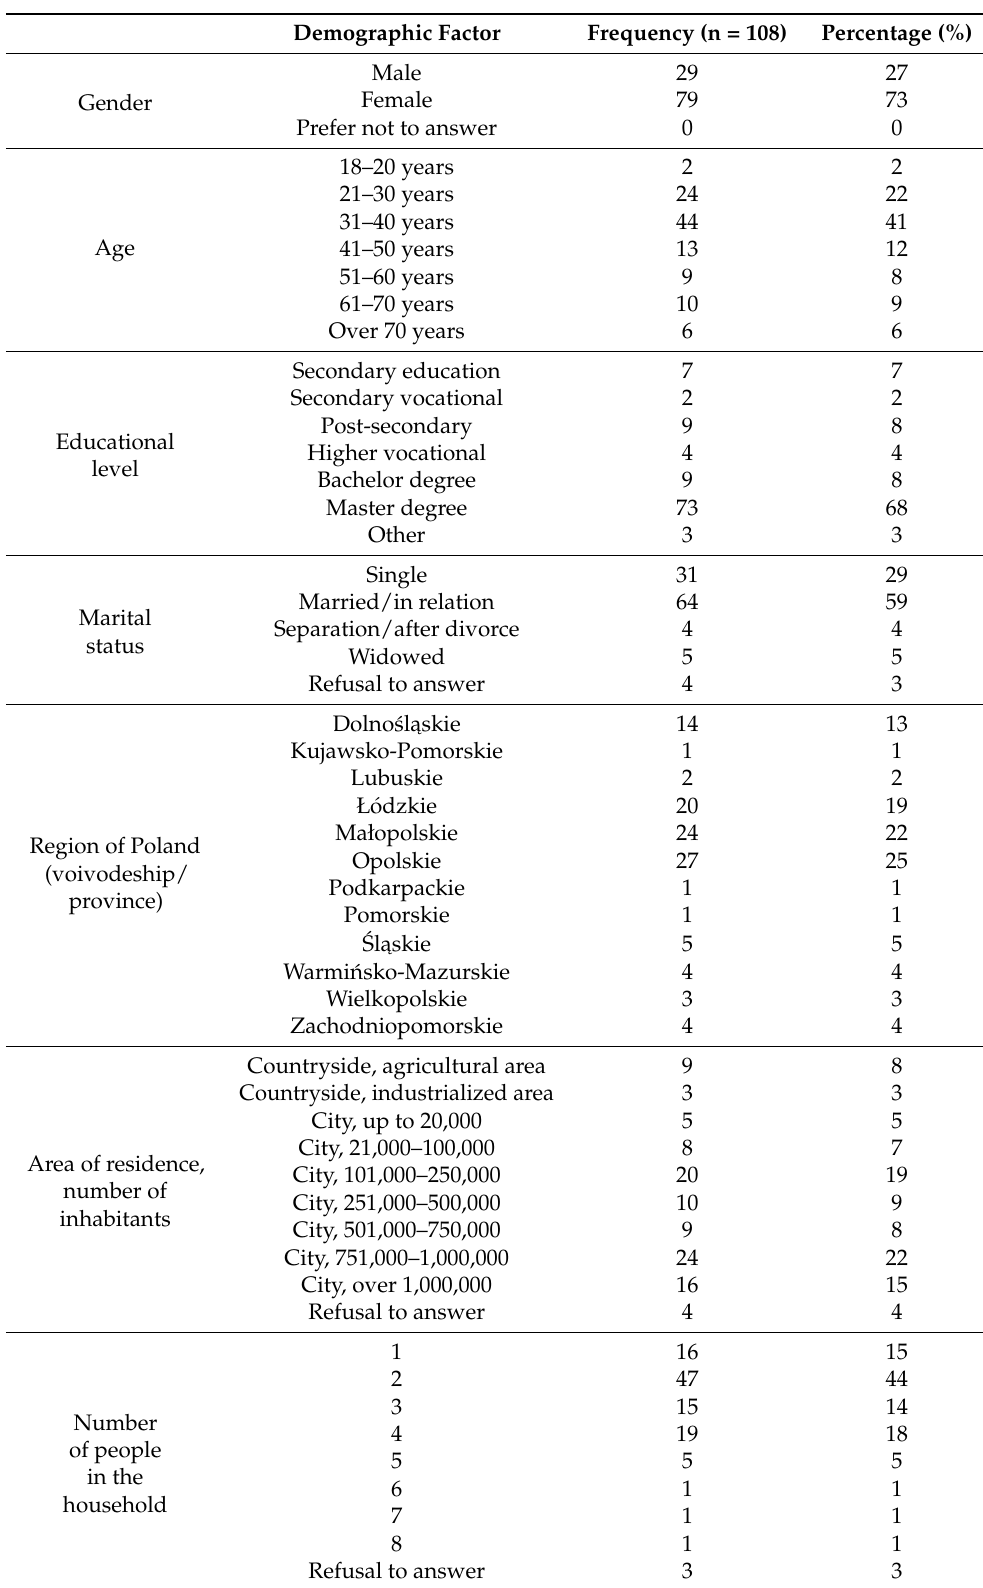
Table 2. Table 2. The socio-demographic characteristics of Polish